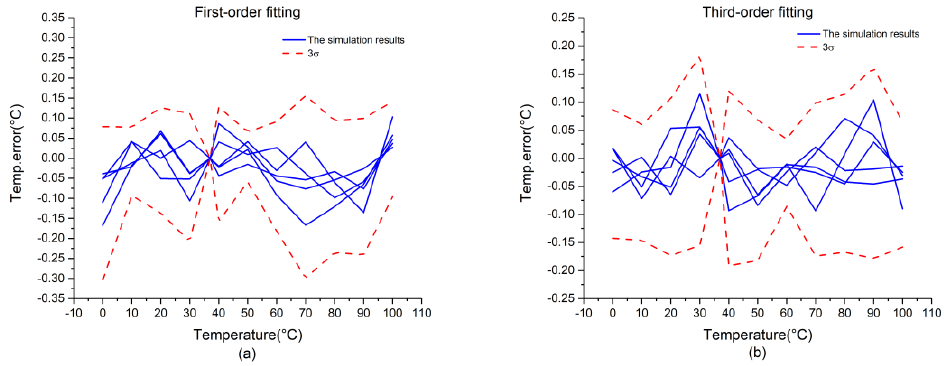
Figure 10. Measurement results of the chip: ( a ) first-order fitting; ( b ) third-order fitting.